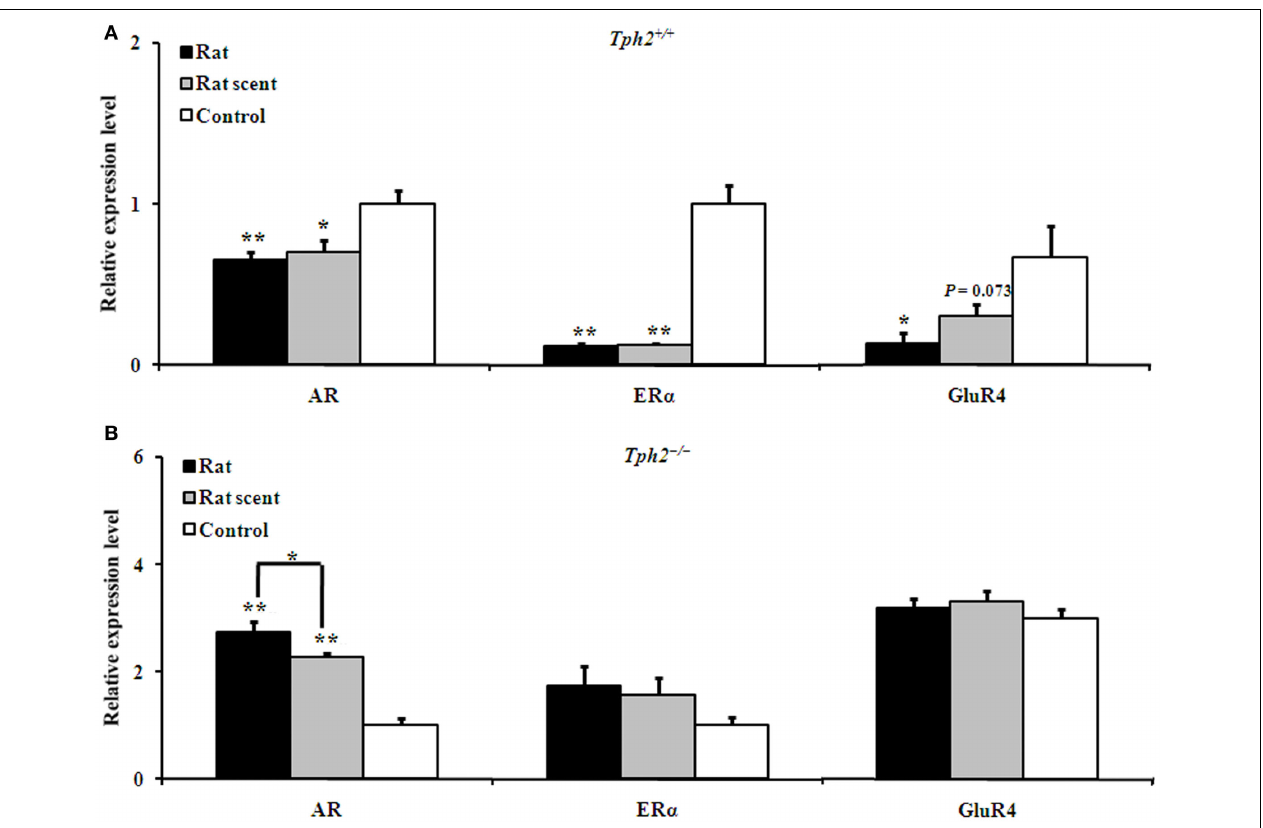
in the same group were ground together for RNA extraction. (B) Expression patterns of AR, ER α and GluR4 in the prefrontal cortex of the rat-exposed, rat scent-exposed and control Tph2 − / − male mice (mean ± SE, n Rat = 7, n Ratscent = 8, n Control = 8). The data were analyzed by One-Way ANOVA, followed by LSD post-hoc t -tests ( ∗ P < 0 . 05; ∗∗ p < 0 . 01).